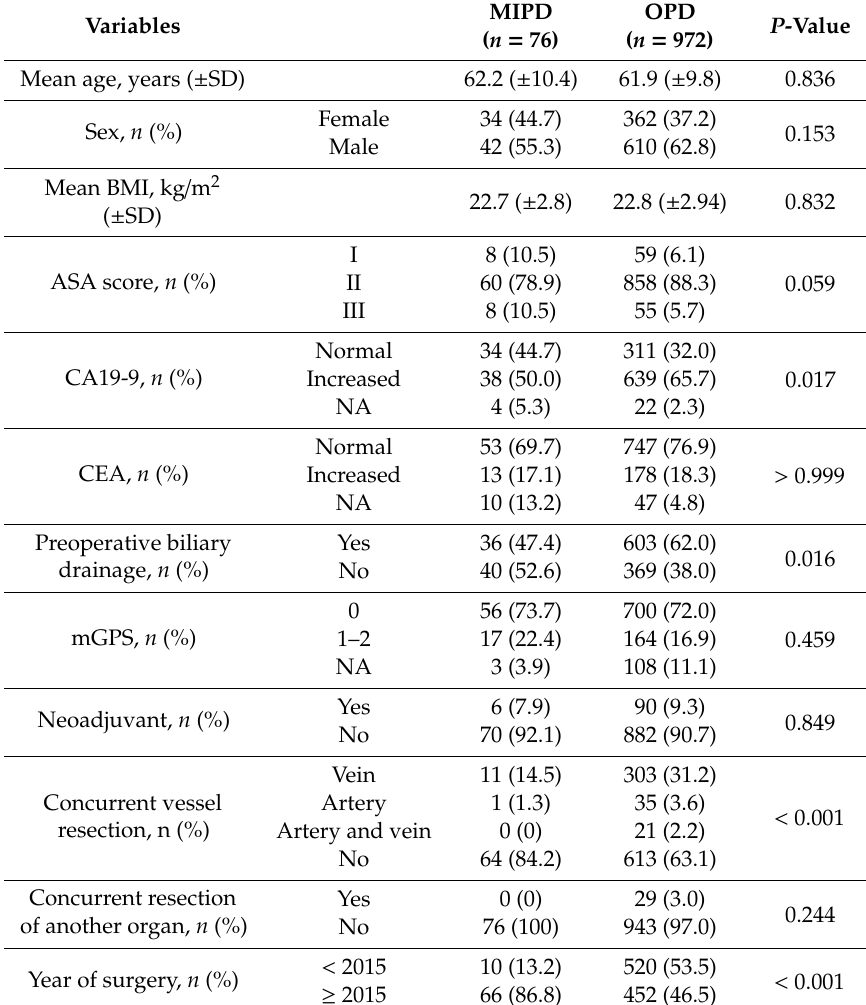
Table 1. Patient